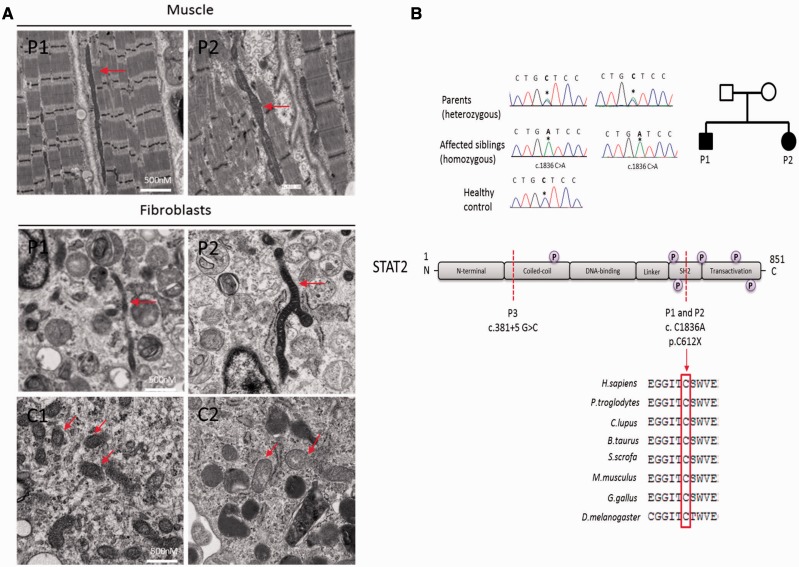

Analysis of muscle and cultured skin fibroblasts. (A) Representative electron micrographs of muscle (longitudinal sections, top) and fibroblasts (bottom) in patients and controls. Red arrows show mitochondria. (B) Top: Electropherograms showing Sanger sequence confirmation of novel homozygous stop gain mutation c.1836 C>A (p.Cys612Ter) in STAT2 identified by whole exome sequencing in Patients 1 and 2. Parents are both heterozygous for the mutation. Bottom: The mutation leads to a stop-gain at amino acid position 612 of the highly conserved SH2 domain of STAT2 protein. P represents phosphorylation sites on STAT2.